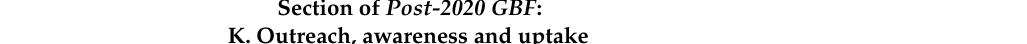
Table 5. Suggested new health-inclusion statements and rationale for “Section K. Outreach, awareness and uptake” within the Post-2020 GBF